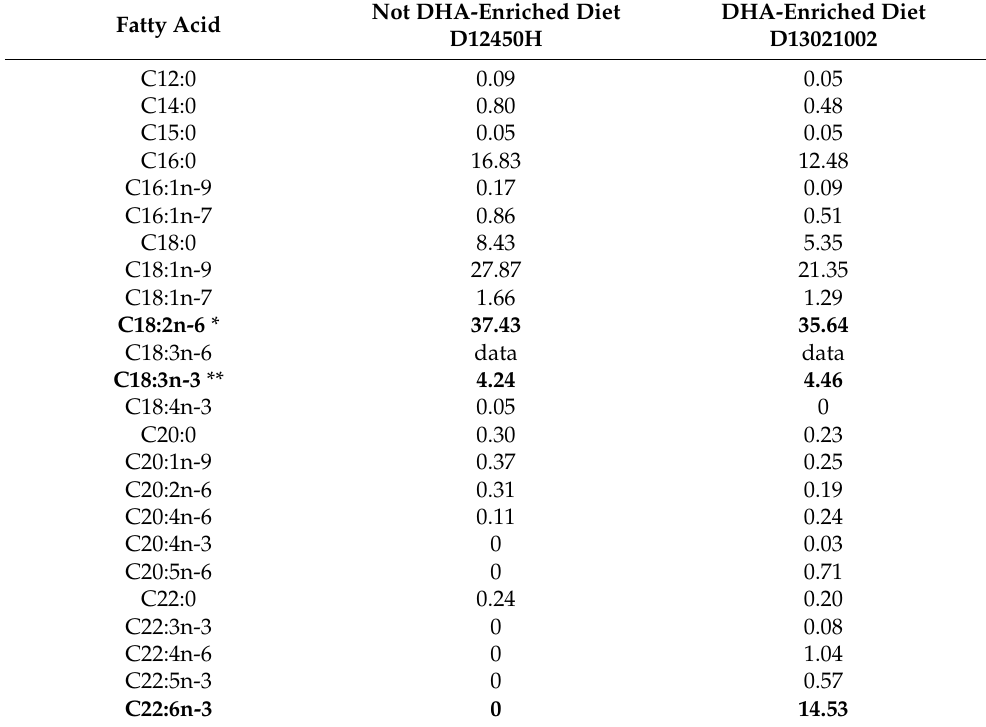
Table 1. Dietary fatty acid